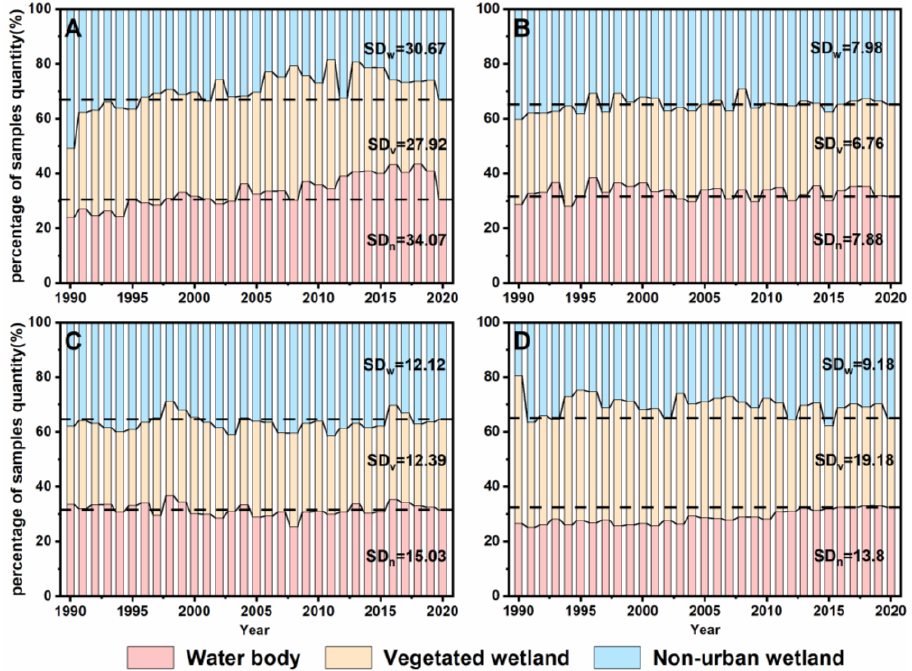
Figure 7. The number of samples after sample migration in this study. ( A–D ) show the number of generated samples for the four study sites (Site(A–D)), respectively. The black auxiliary dotted lines show the initial size of samples in 2020. The SDw, SDv, and SDn indicate the standard deviation of the sample number for the water body, vegetated wetland, and non-urban wetland from 1990 to 2020, respectively.